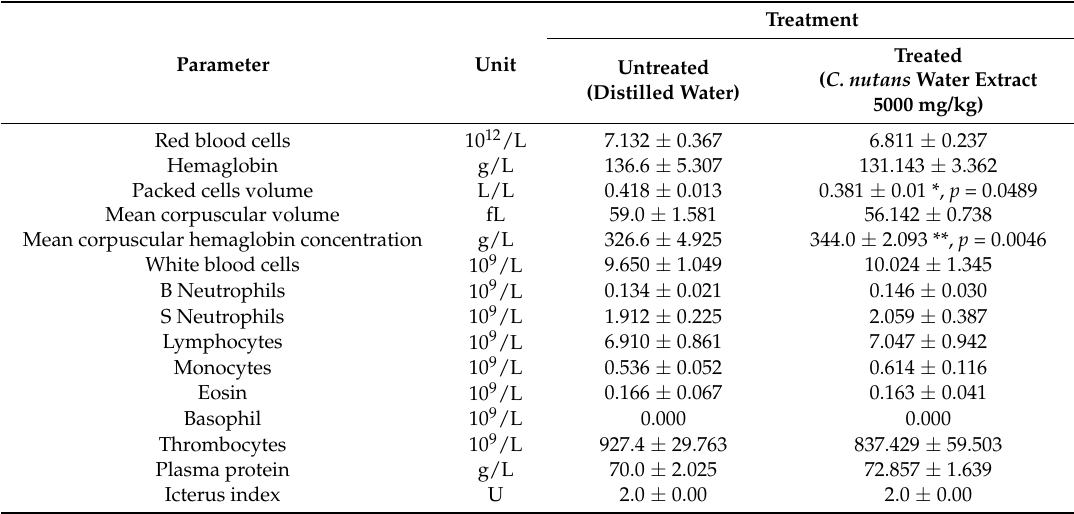
Table 1. Hematology analysis on the acute oral toxicity effect of Clinacanthus nutans water leaf extract in Sprague Dawley